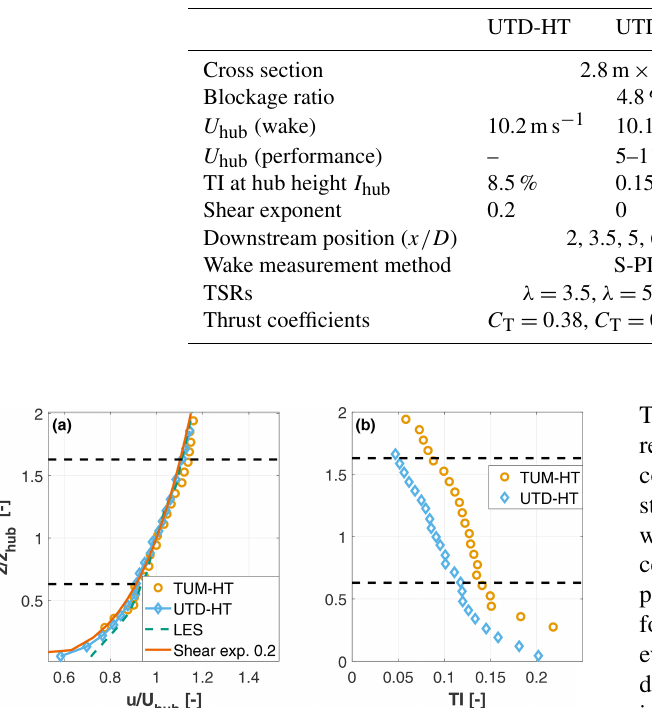
Table 2. Summary of test conditions in the UTD and TUM boundary layer wind tunnels.